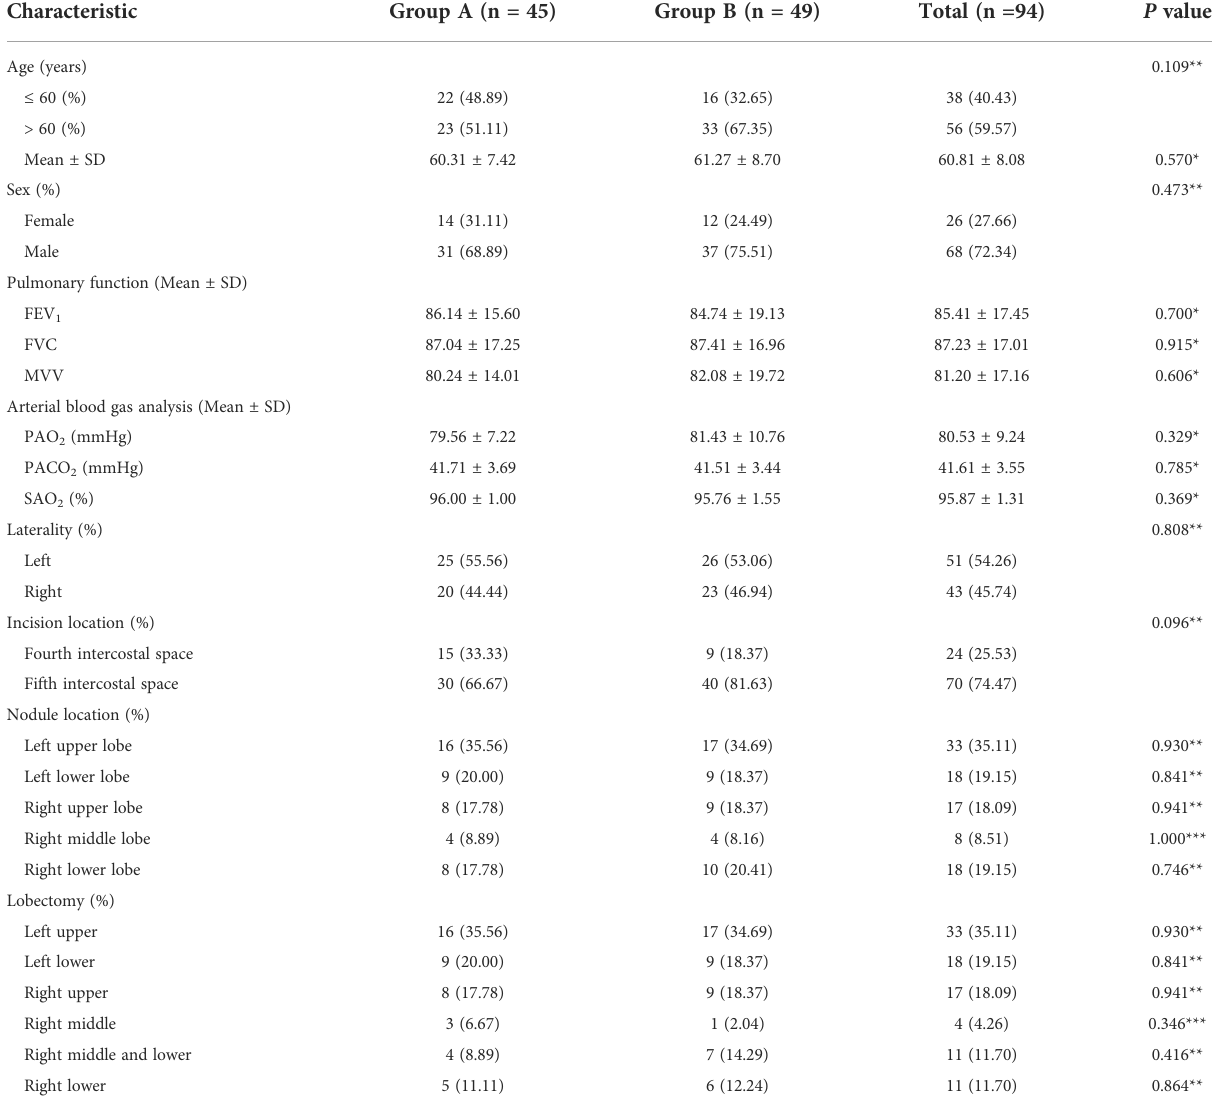
TABLE 1 Baseline patient